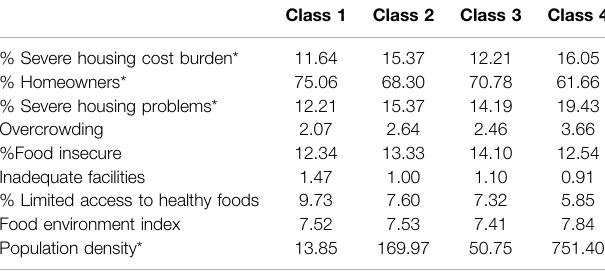
TABLE 10 | Discriminant analysis structure coef fi cients for housing/food variables by latent class.